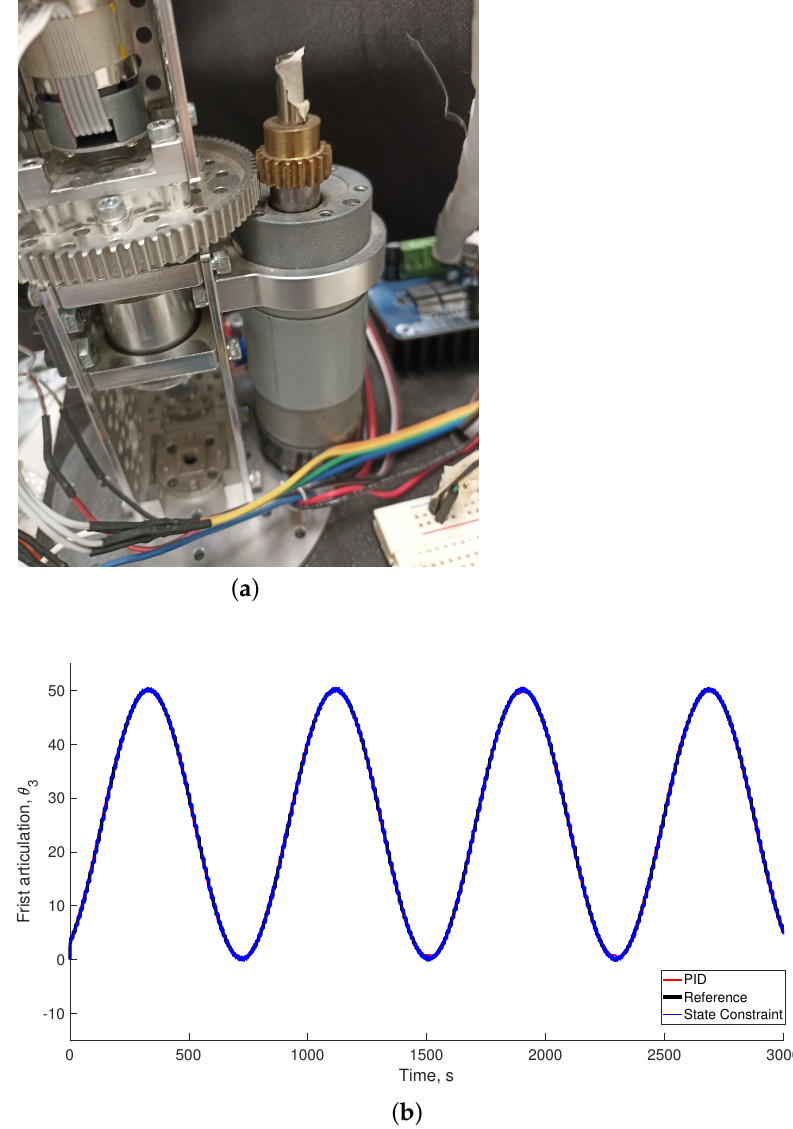
Figure 6. ( a ) Photograph of the electromechanical configuration for the third articulation θ 3 ; ( b ) comparison of the controlled motion for the third articulation ( θ 3 ) when the PID and adaptive control with state constraints are